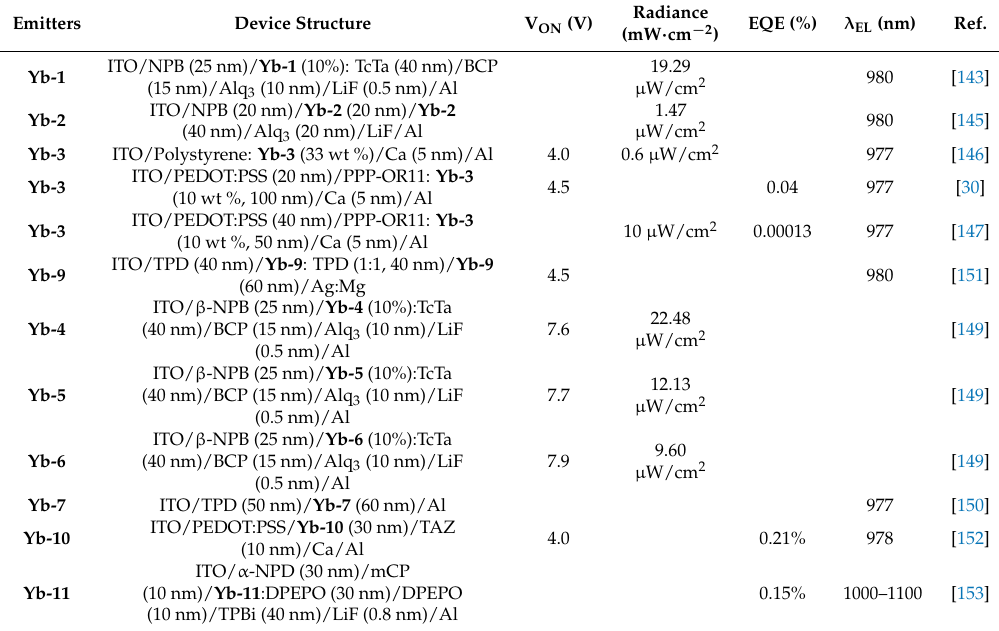
Table 7. Summary of electroluminescent properties of organic light-emitting diodes (OLEDs) fabricated with